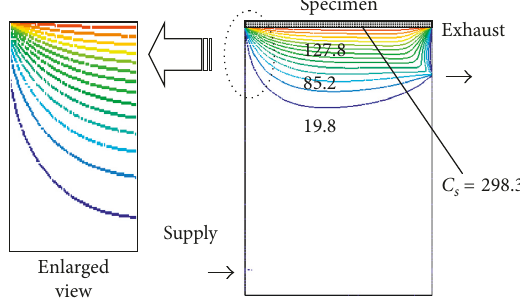
Figure 9: DEHP concentration distribution: air change rate 1.5 (cid:30)